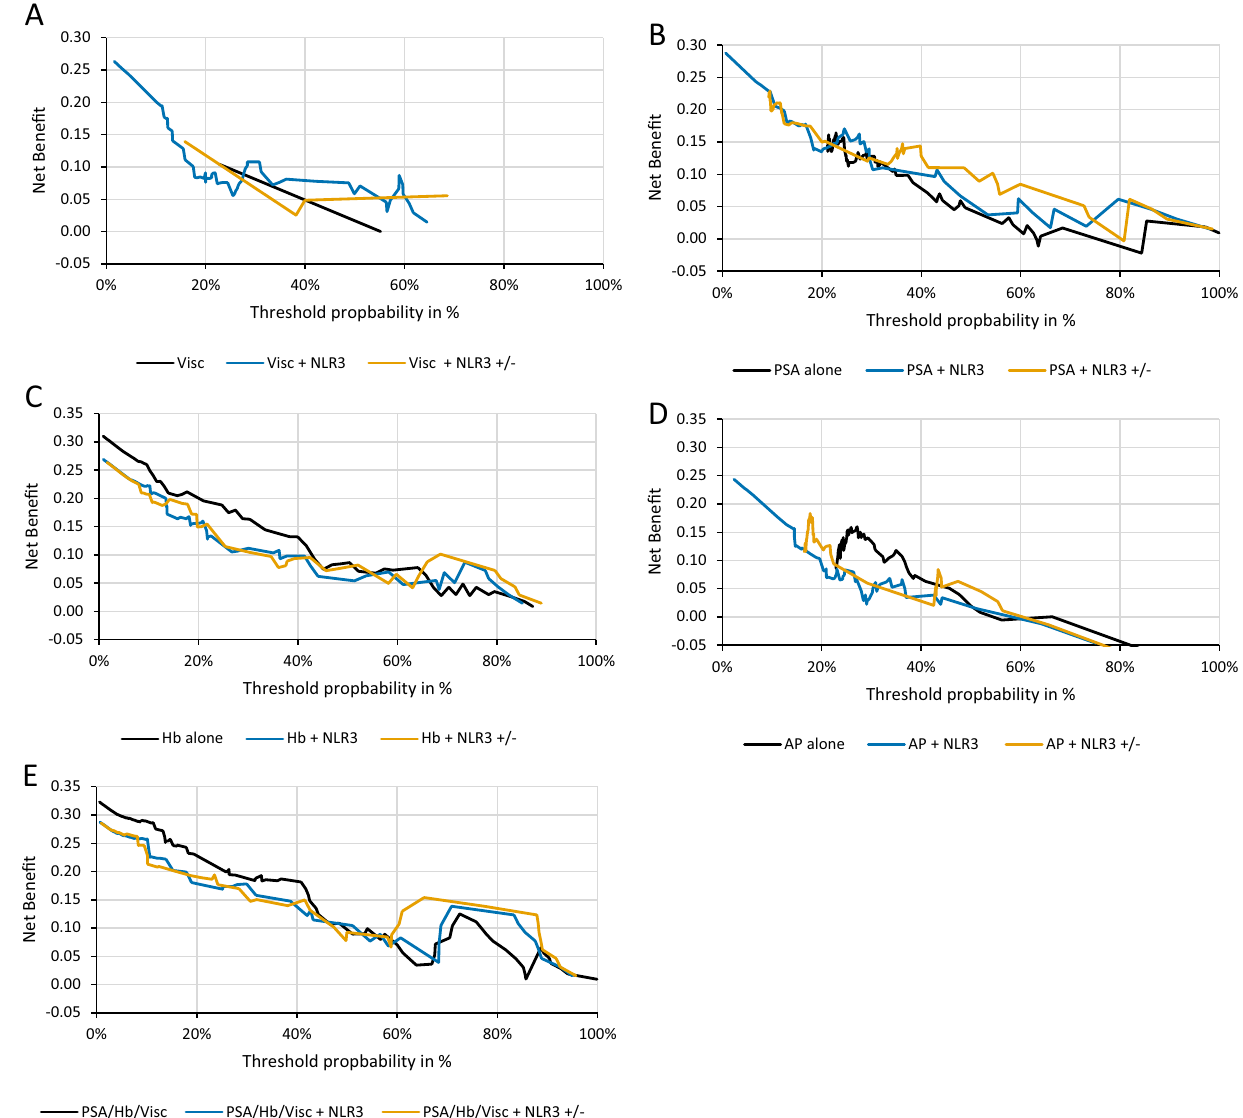
Fig. 4 Decision curve analysis of multivariable models with the respective biomarker “NLR3” or “NLR3 positive or negative” A visceral metas- tasis, B PSA, C haemoglobin, D alkaline phosphatase and E PSA, haemoglobin, and visceral metastasis. NLR3 NLR slope over the first 3 cycles, NLR3 +/− positive or negative slope over the first 3 cycles, Visc visceral metastasis, Hb haemoglobin, AP alkaline